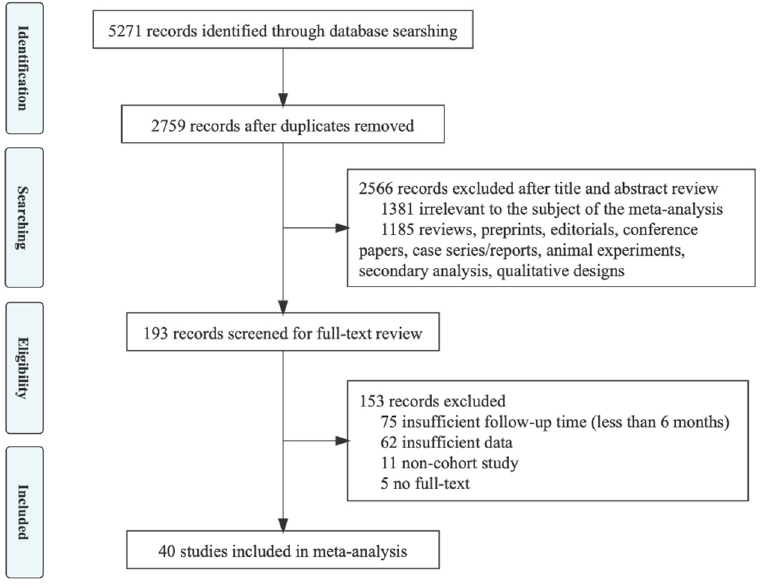
Figure 1. Flowchart of the study selection.